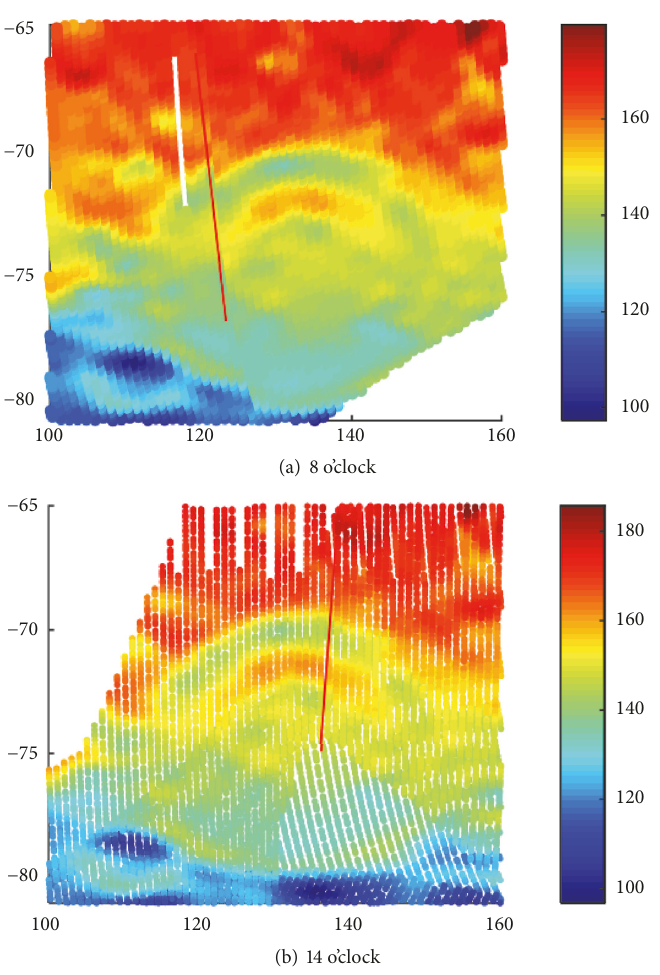
Figure 3: CELMS data at 8 (a) and 14 (b) o’clock (unit: K).